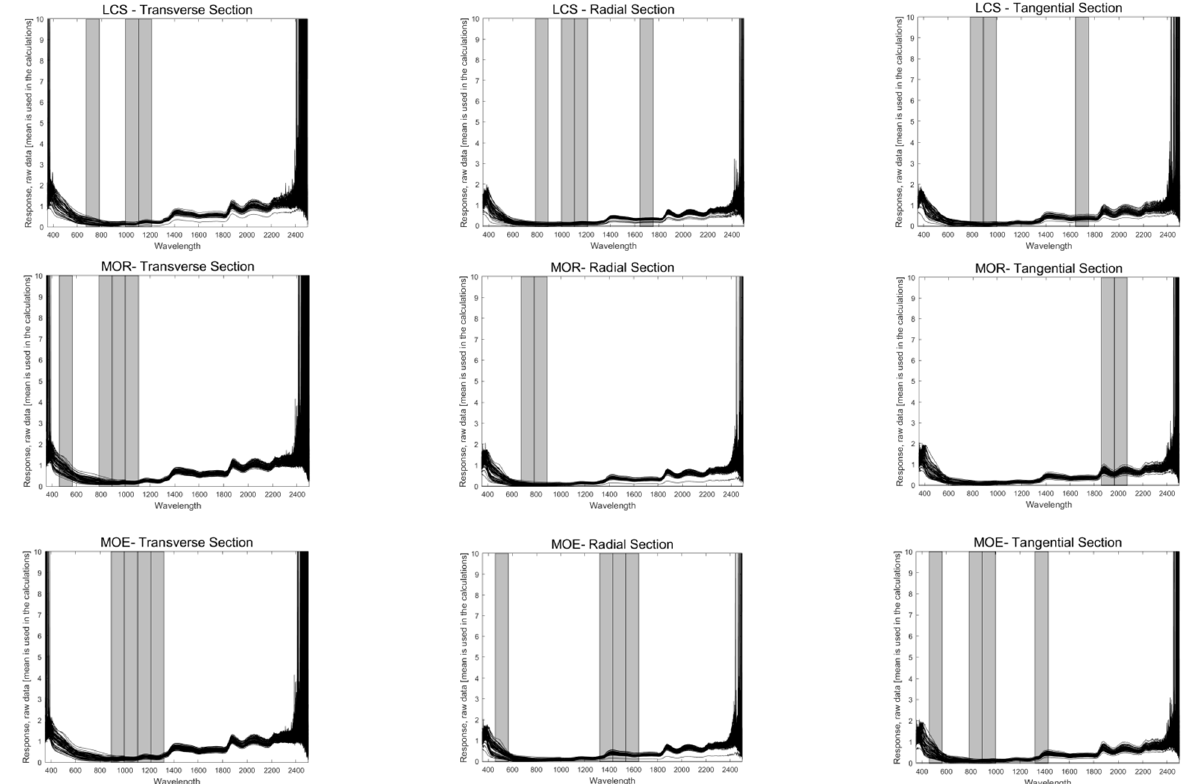
Figure 8. Band screening results of wood mechanical properties Vis ‐ NIRS based on SiPLS.